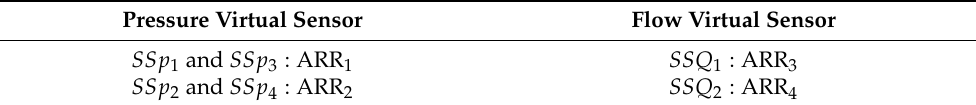
Figure 6. Traditional diagnostic bond graph of landing gear R/E hydraulic system. Table 2. Set virtual sensors and corresponding